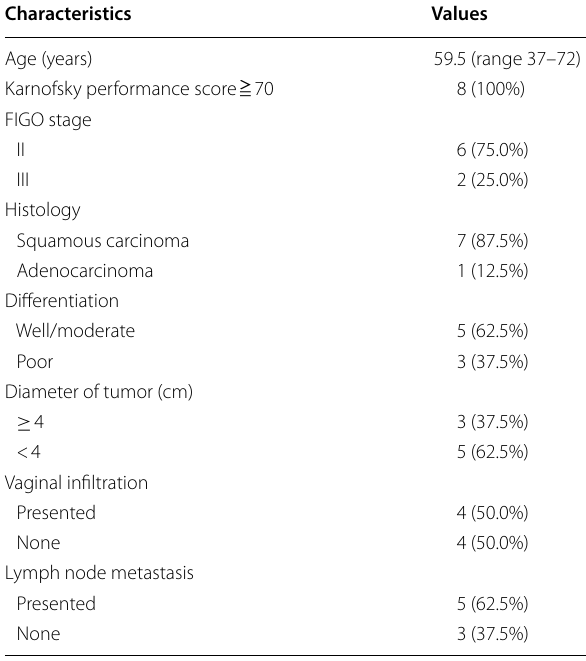
Table 1 Patient